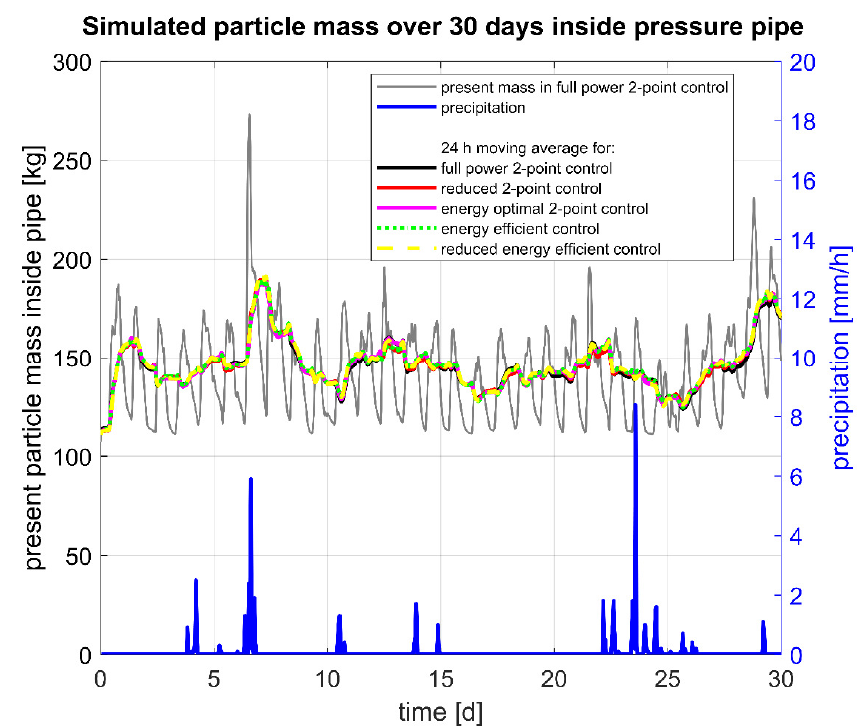
Figure 7. Sediment transport simulation for five different pumping modes over 30 days. Present particle mass inside pressure pipe on left axis and precipitation data on right axis (rain events are measured by a German Weather Service (DWD) meteorological station located inside the catchment area). The recorded rain events are shown on the right axis (blue line). Due to the size of the catchment area and the limitation of the connected areas on main roads (see also [3]), not all storm runoffs finally reach the PS. A good example was recorded at day 6. The storm runoff quickly enters the upstream sewer and subsequently the pressure pipe. The present particle mass increases up to ≈270 kg.